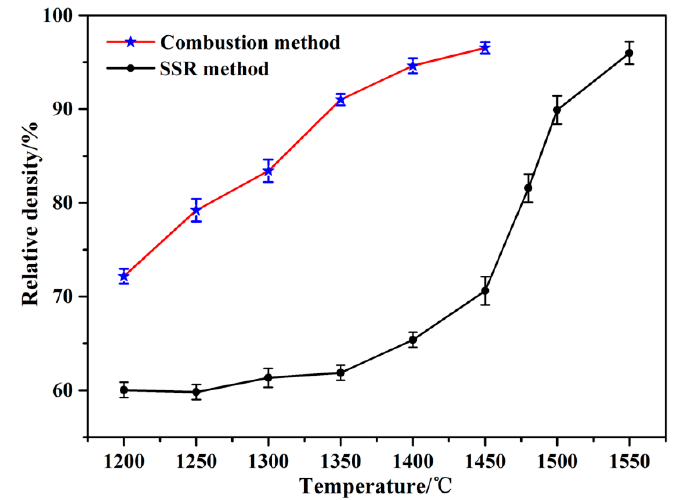
Figure 2. Relative densities of La 0.8 Ca 0.2 CrO 3 ceramics synthesized by the two methods.